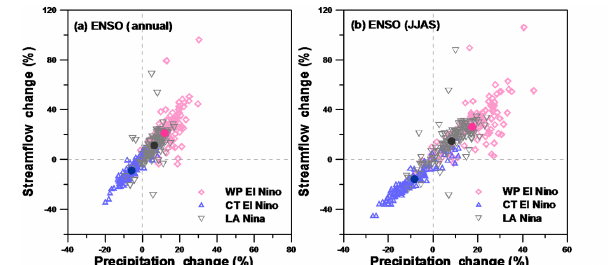
Figure 7. Scatter plot of percentage change anomaly (departures from the 1971–2000 normal) changes between precipitation and streamflow in different climate conditions. (a) and (b) show dur- ing annual and JJAS season in strong ENSO events in the 113 sub- watershed in